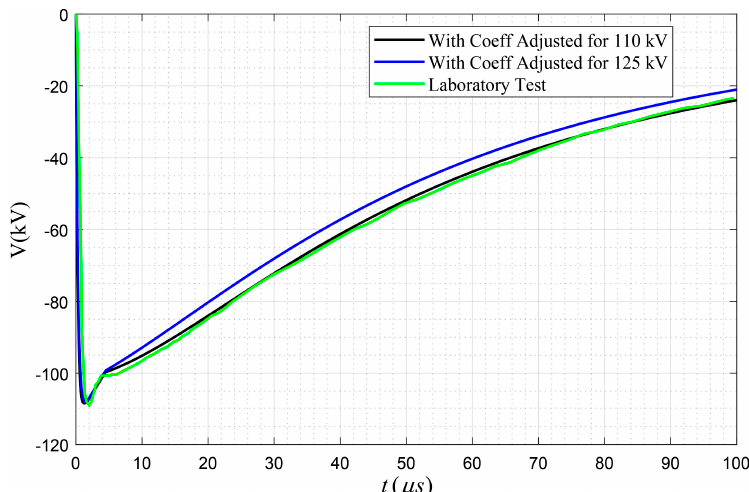
Figure 10. Comparison of the 110 kV laboratory impulse voltage with the impulses simulated in EMTP-RV by using the coefficients of double exponential functions adjusted for the 110 kV and 125 kV impulses.